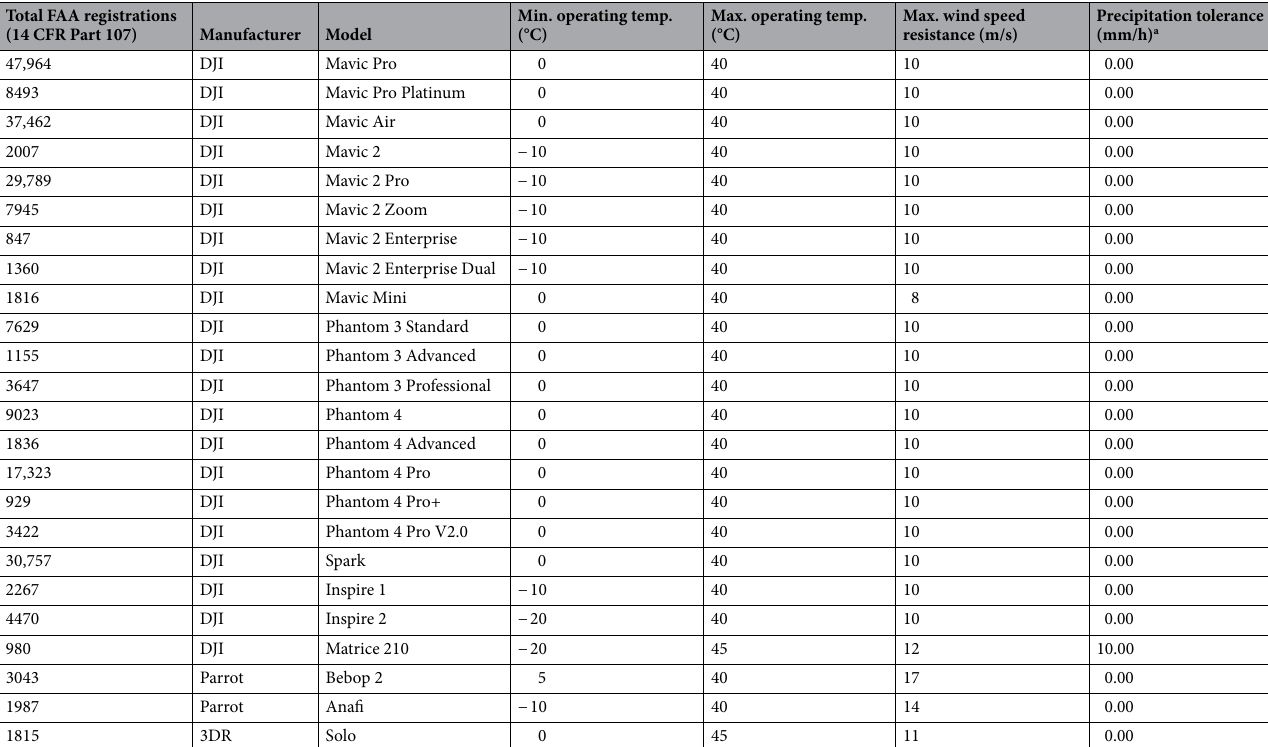
Table 1. Condensed list of top small-drone commercial registrations in the United States as of 05 May 2020. a Precipitation tolerance values of 0.00 mm/h were derived from qualitative descriptions (e.g., “this aircraft cannot be operated in rain”).